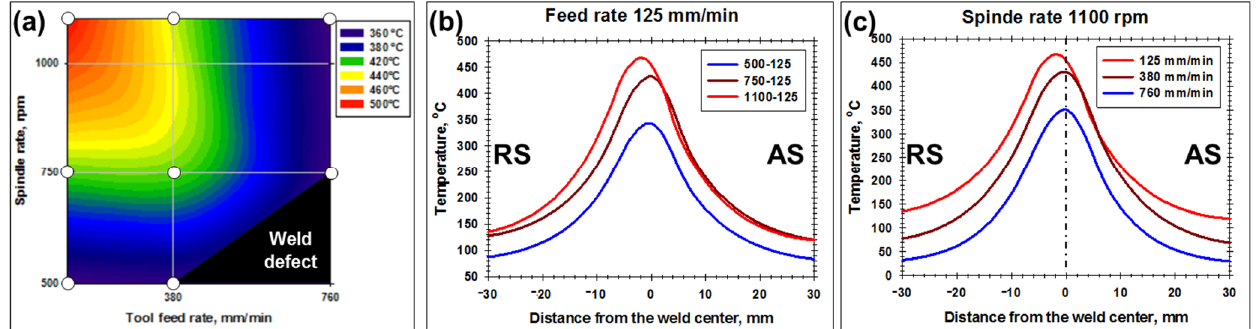
Figure 6. The combined effect of welding variables on the peak temperature ( a ), and typical effect of spindle rate ( b ) and the tool feed rate ( c ) on the temperature profiles calculated across the weld mid-thickness. In all cases, the temperature data were simulated for the weld section directly behind the tool probe. In ( a ), circles indicate the welding conditions for which the temperature data were actually simulated. In ( b ), the data for the welds produced at the feed rate of 125 mm/min are shown. In ( c ), the data for the welds produced at the spindle rate of 1100 rpm are shown.